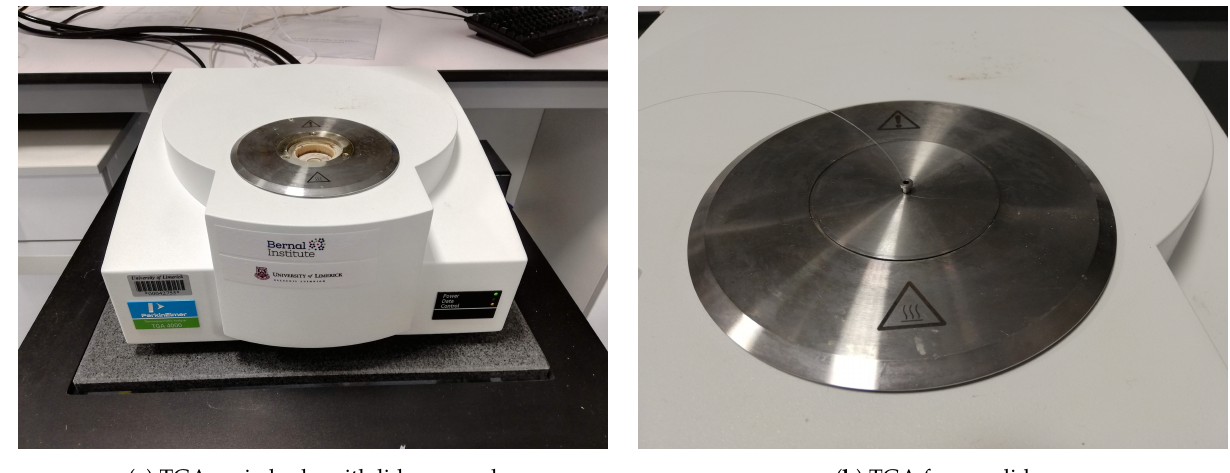
Figure 12. ( a ) TGA main body; ( b ) TGA furnace lid with a sensor SMF